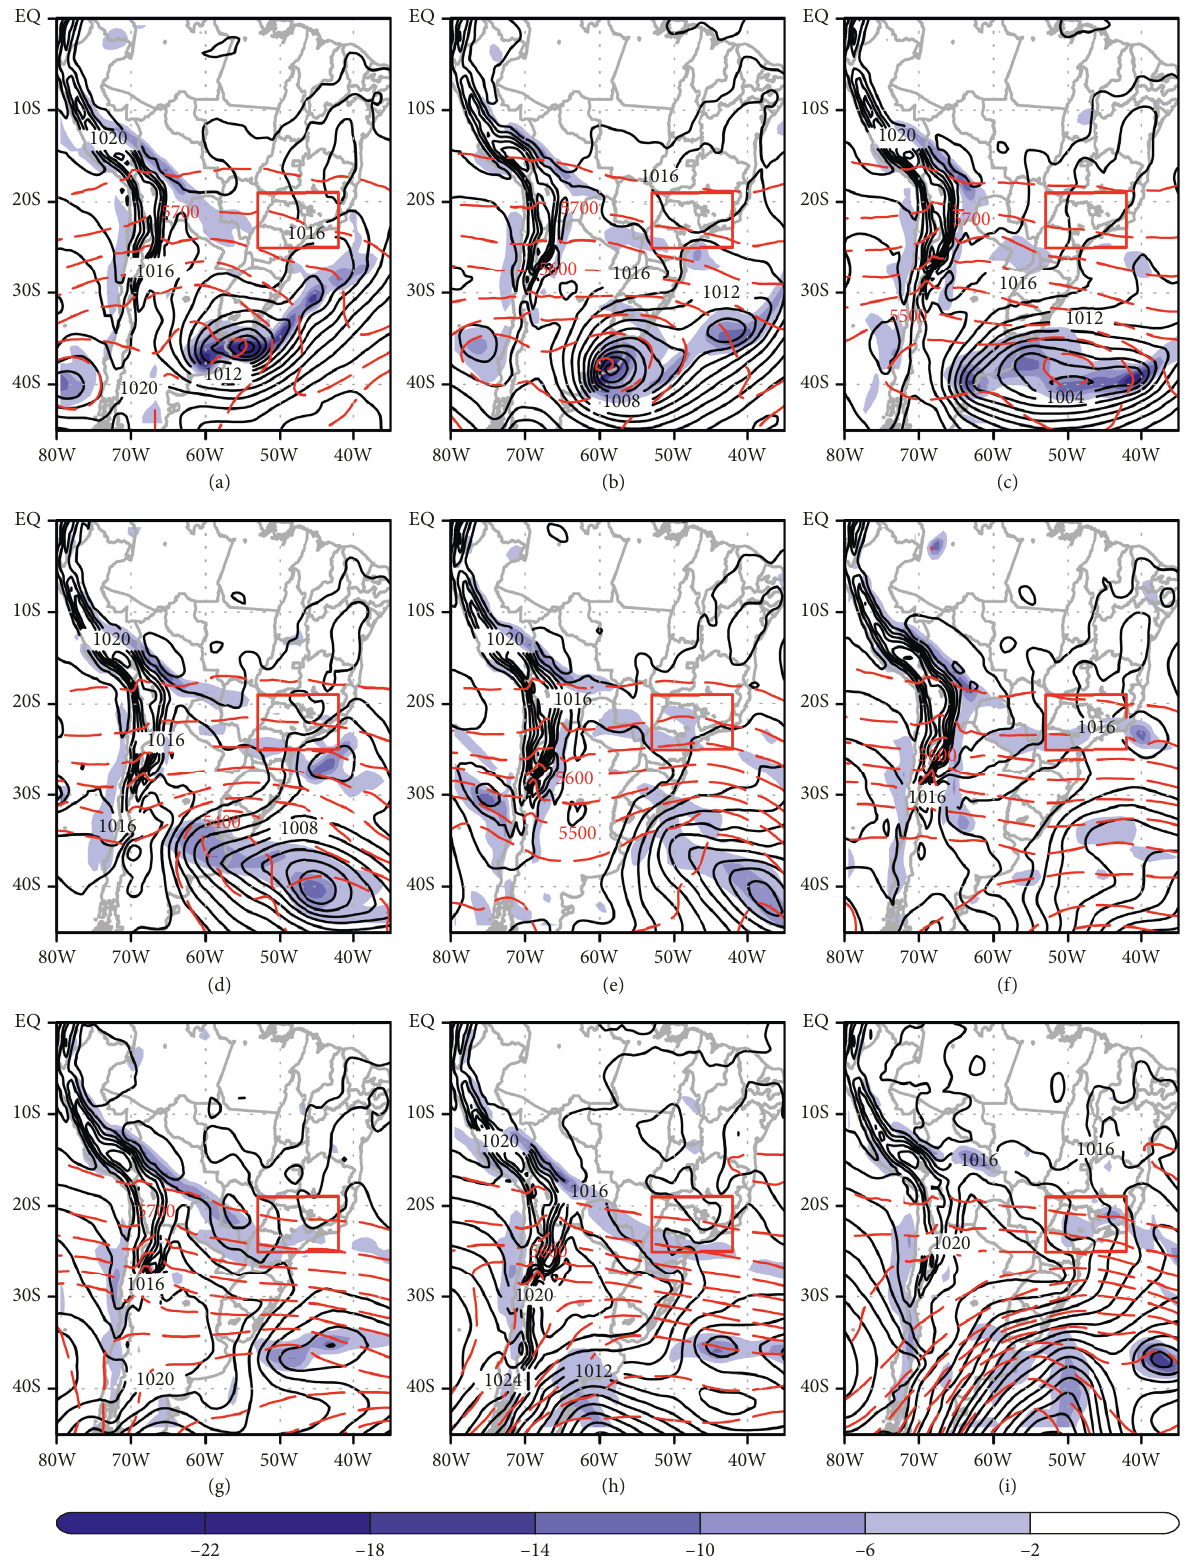
Figure 5: Mean sea level pressure (black contours; hPa), geopotential height (red-dashed contours; gpm), and relative vorticity 5 1 ) at 850hPa at 12 UTC on (a) 30 May, (b) 31 May, (c) 01 June, (d) 02 June, (e) 03 June, (f) 04 June, (g) 05 June, (h) 06 June, (shaded; 10 s · and (i) 07 June, − −